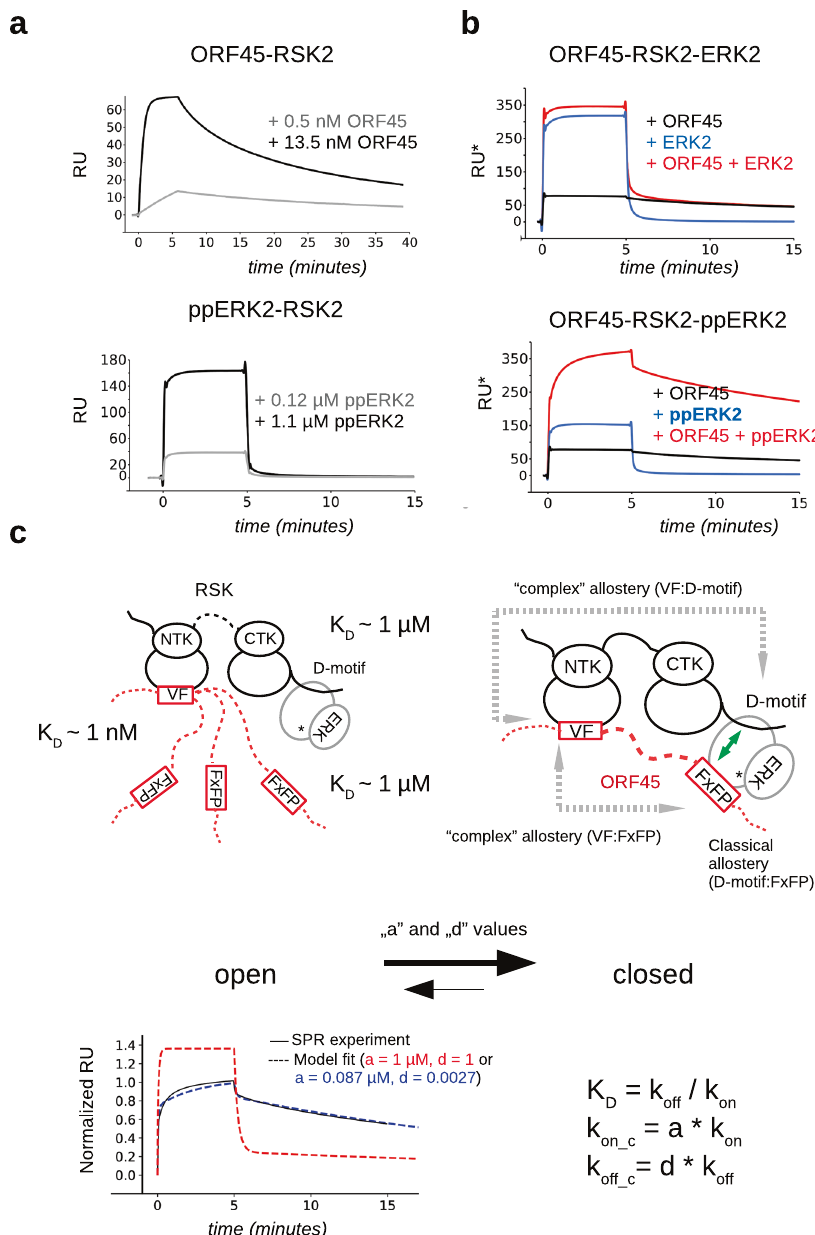
Fig. 4 Characterization of ORF45-RSK2 binding and its effect on ppERK2-RSK2 binding. a Binding between RSK2 and ORF45 or ppERK2 analyzed by SPR. ORF45 or ppERK2 were injected over the immobilized RSK2 surface in two different concentrations for 5 min (association phase) and then the dissociation of the complex was monitored in time. RU response units. b Comparison of ternary complex formation with ERK2 or ppERK2. Results of kinetic binding experiment using nonphosphorylated ERK2 (upper panel) or ppERK2 (lower panel) where proteins were injected over the immobilized RSK2 surface alone (10 μ M ORF45 in black or 1 μ M ERK2 in blue) or together (in red). c Schematics of the ppERK2-RSK2-ORF45(16-76) ternary complex. The “ closed ” ternary complex, which could form from three different “ open ” complexes (but only one of them is shown on this panel), is formed by three linear motif (VF, FxFP, and D-motif) mediated protein-protein contacts. The binding af fi nity of the binary interactions between VF(ORF45):NTK(RSK2), FxFP(ORF45):ppERK2, and D-motif(RSK2):ppERK2 are indicated. Note that VF:NTK binding is ~1000-fold stronger and has low k off compared to the other two interactions. Classical vs “ complex ” allostery within the ternary complex are highlighted with green or gray arrows, respectively. In the simulation of SPR data, the difference between binding rates in the binary versus the ternary complex could be introduced by the global “ a ” and “ d ” values affecting the k on or the k off of complex formation, respectively. The lower panel shows the simulation results (dashed lines) overlaid with the corresponding experimental binding curve (solid black line) where the ternary k on and k off are the same as in the binary complexes ( a = 1 and d = 1; red) or adjusted by the fi tted a and d values (blue). The apparent kinetic binding parameters in the closed complex ( k on_c or k off_c ) are obtained by the multiplication of the binary binding constants by a or d . Source data are provided as Source data fi